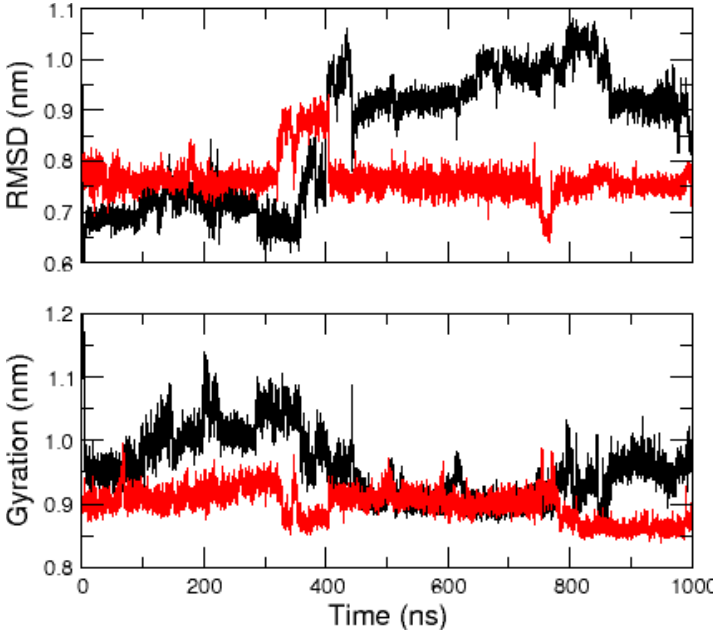
Figure 1. Time evolution of the RMSD relative to the 2L86 structure ( top ) and of the radius of gyration ( bottom ) for the amidated ( black line) and non-amidated ( red line) hIAPP